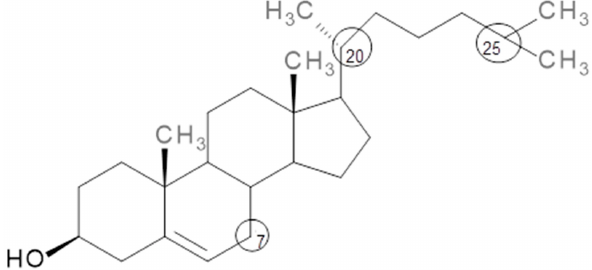
Figure 1. Cholesterol structure. Circles indicate the most reactive carbon.